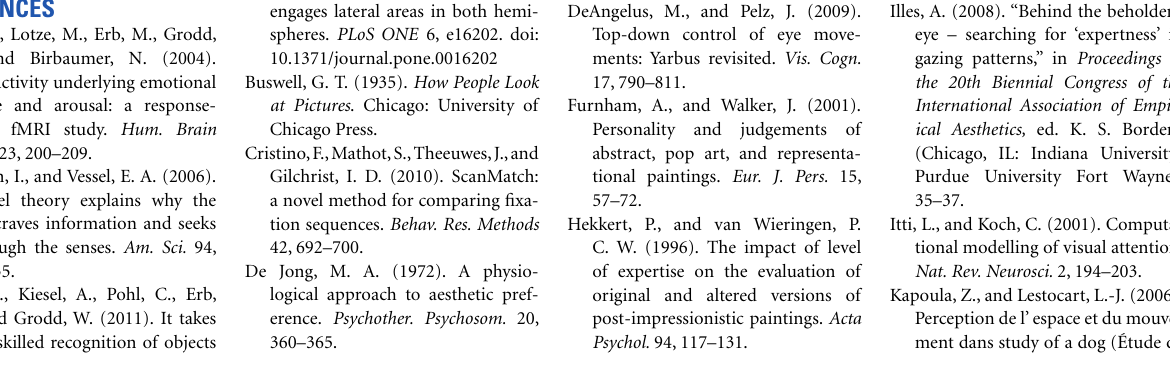
for Figure 5 : Eugène Boudin (French, 1824–1898), Villefranche , c. 1891. Oil on panel, 16 1/16 (cid:2)(cid:2) × 12 7/8 (cid:2)(cid:2) (40.8 cm × 32.7